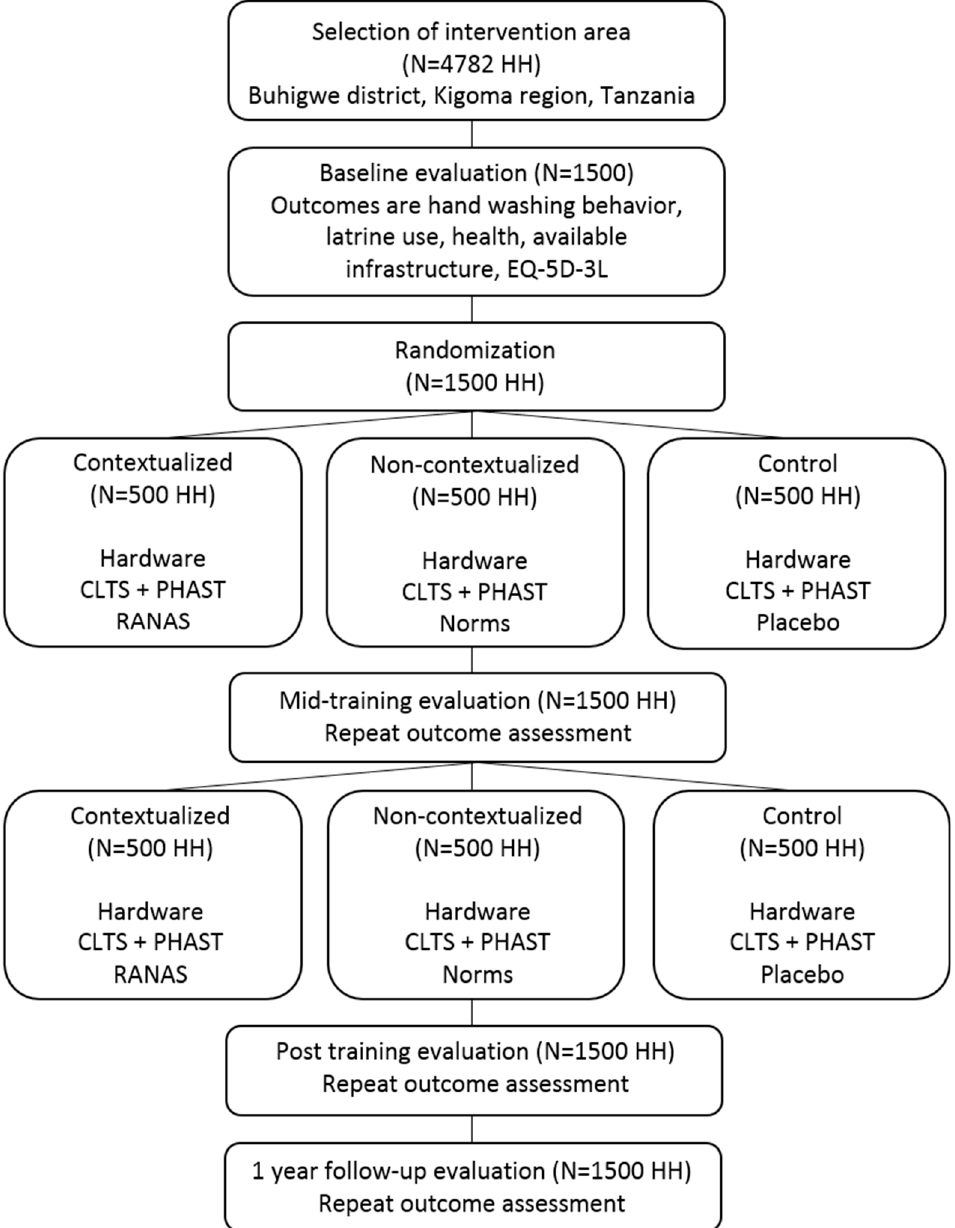
Figure 1. Summary of the study design and intervention protocol. HH = households; CLTS = Community-Led Total Sanitation; PHAST = Participatory Hygiene and Sanitation Transformation; RANAS = Risks Attitudes Norms Abilities Self-regulation; EQ-5D-3L = Quality-of-Life questionnaire.